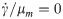
Biofilm growth under a shear flow.The biofilm shapes are shown at the non-dimensional time T* = 140 (T* = t(s)×μm(s−1)); (a) γ˙/μm=0, very rough shape; (b) γ˙/μm=108, wavy pattern; (c) γ˙/μm=144, flat shape. As shear rate increases the biofilm surface changes from very rough to wavy and then smooth.